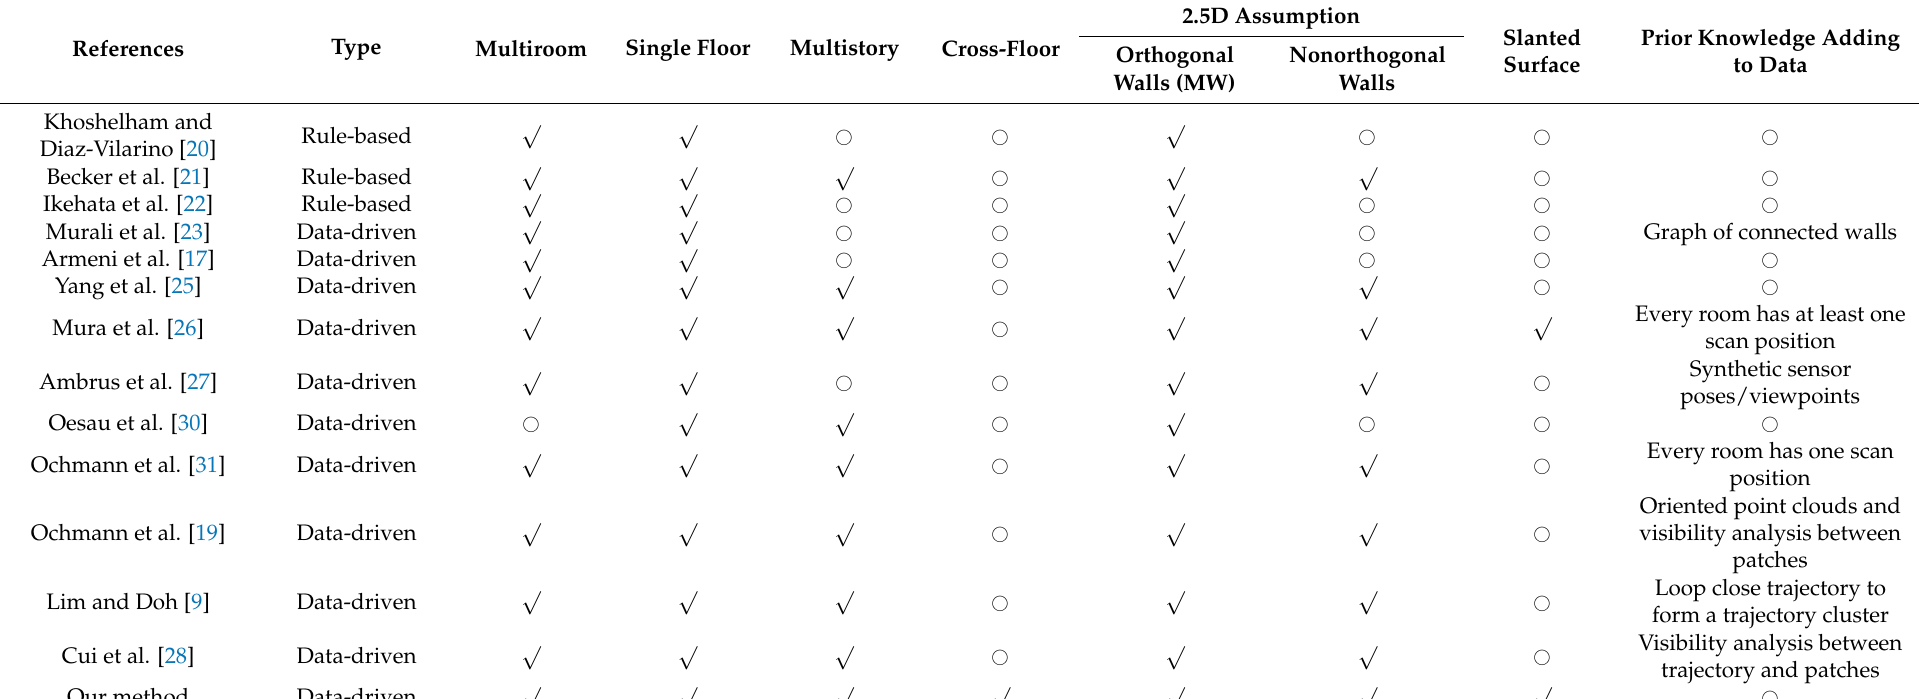
Table 1. Overview of recent 3D layout reconstruction methods for indoor